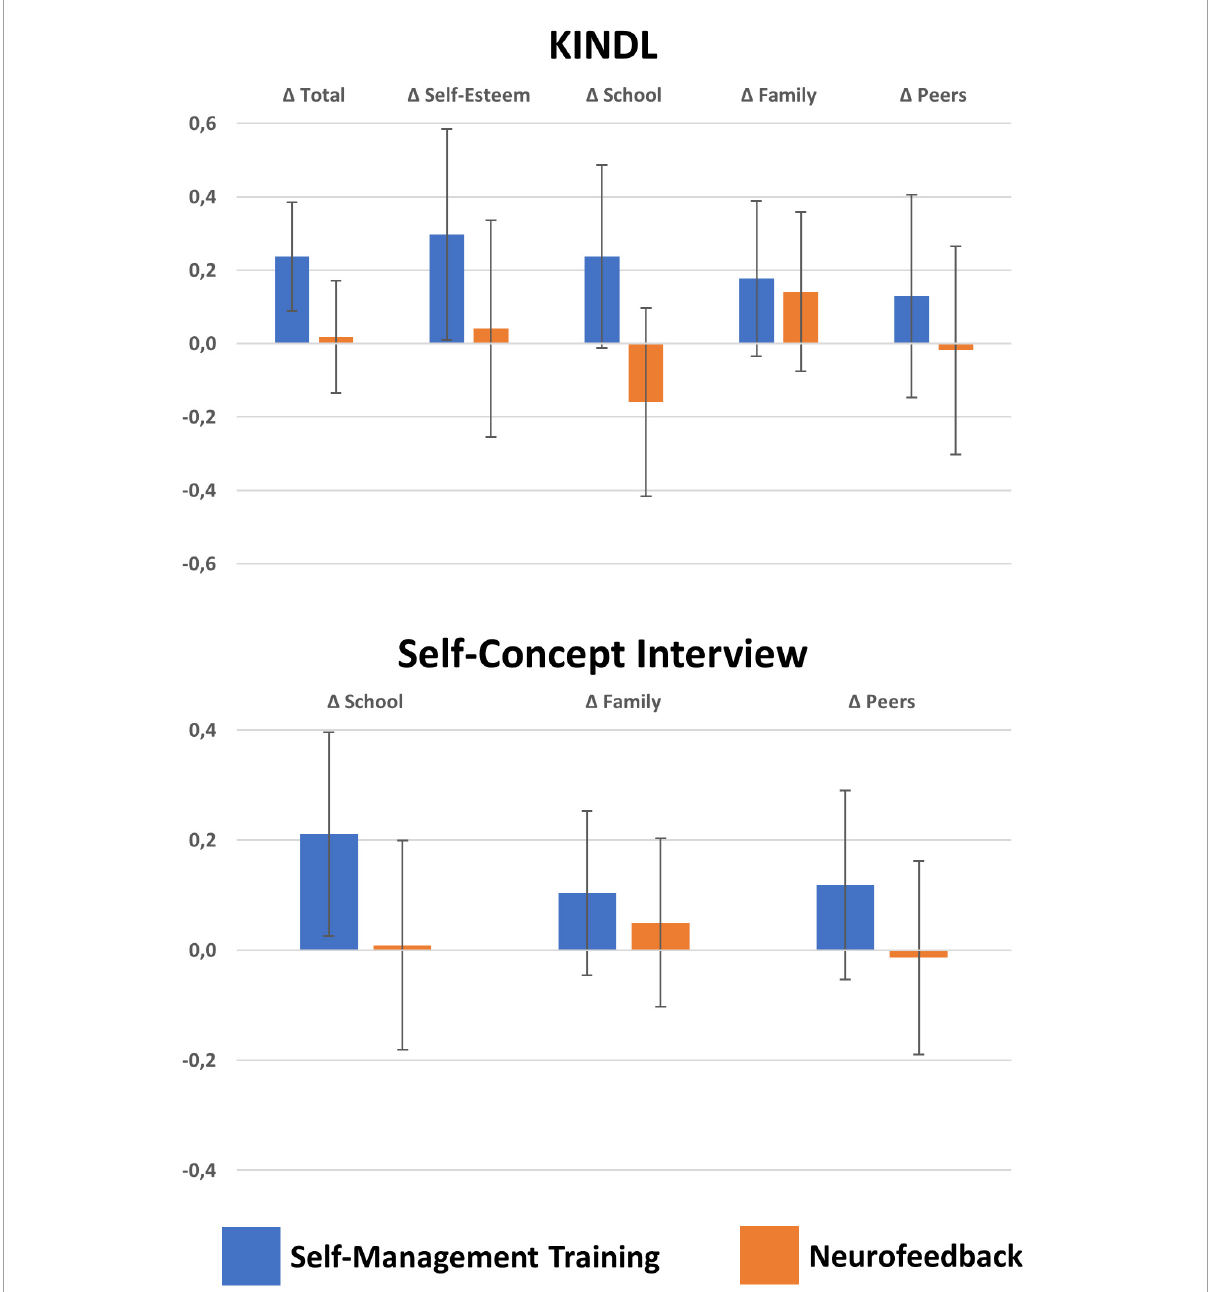
FIGURE3 Changes in quality of life and self-concept. Means and confidence intervals with p = 0.05 of KINDL quality of life and self-concept scores. Significant improved quality of life was detected after SMT in self-esteem and marginally in school and family situations ( p < 0.10), as well as self-concept at school whilst NF was not followed by any significant improvements. Direct comparisons between treatments revealed superiority of SMT over NF regarding quality of life in